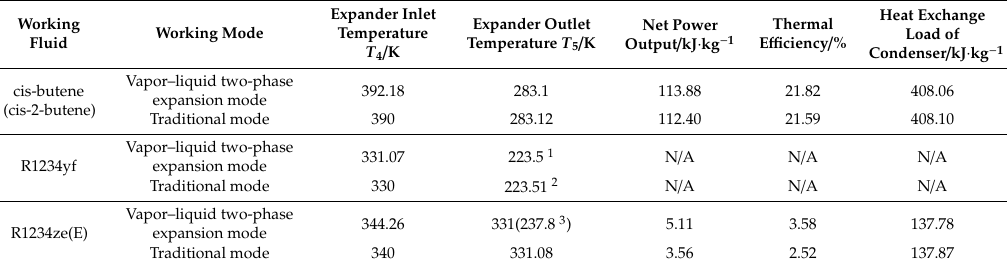
Table 2. Thermodynamic performance of the remaining three working fluids in the subcritical cycle model when the working conditions at the expander inlet are